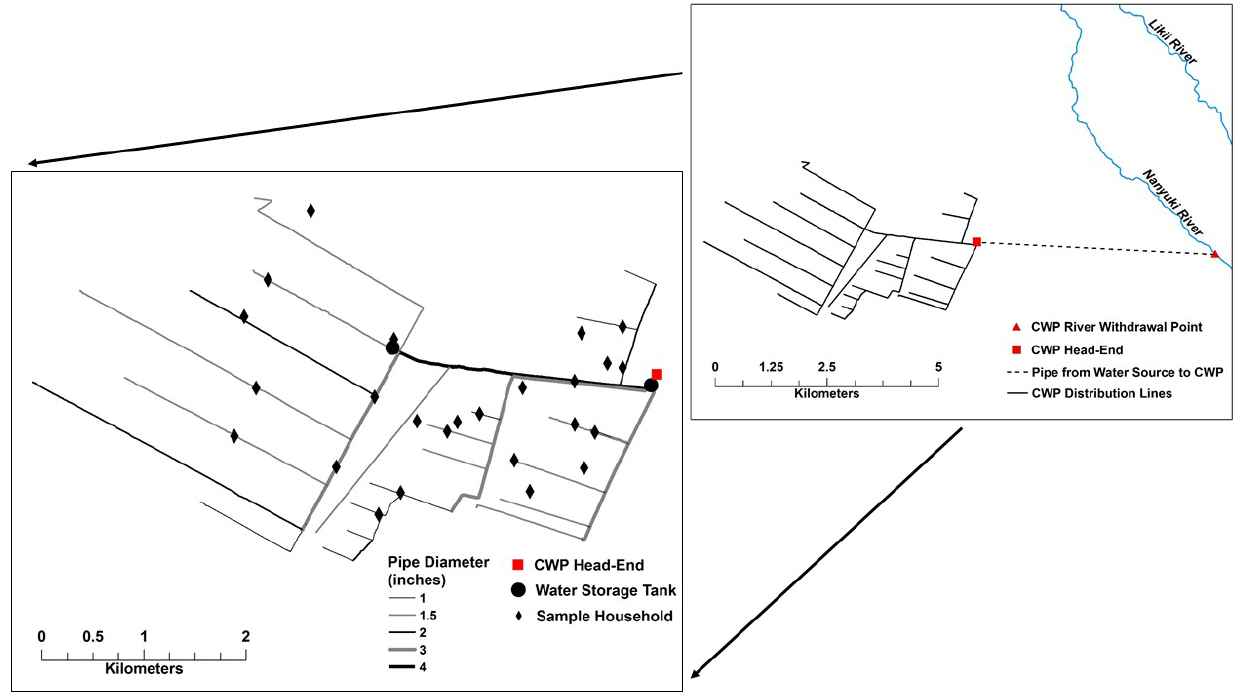
Fig. 2. The layout of a CWP showing both the position along a river (right) and the configuration of distribution lines